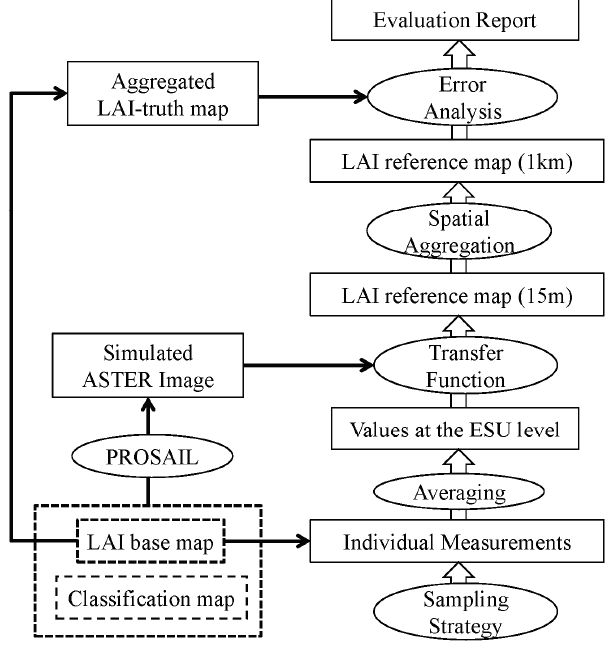
Figure 1. Sampling strategy evaluation framework based on the PROSAIL model